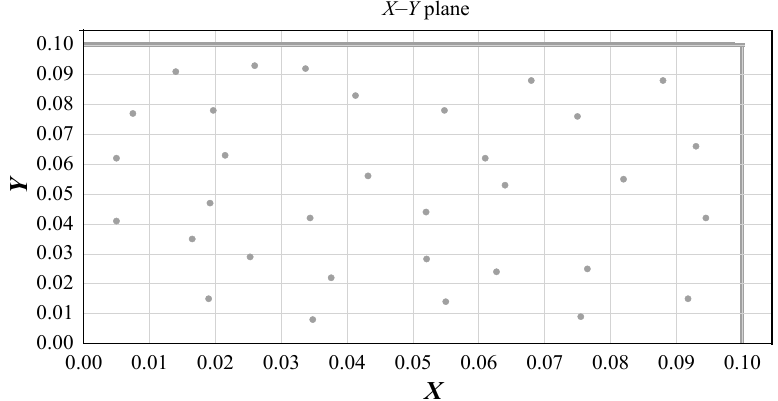
Figure 11. Three-dimensional random aggregate model of concrete.